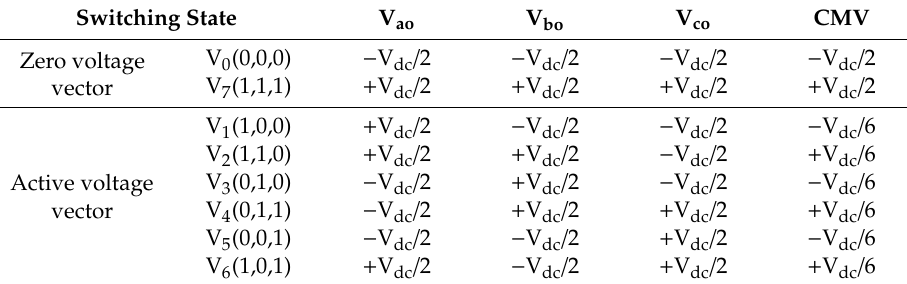
Table 1. Inverter Pole Voltage and CMV by Voltage Vector.